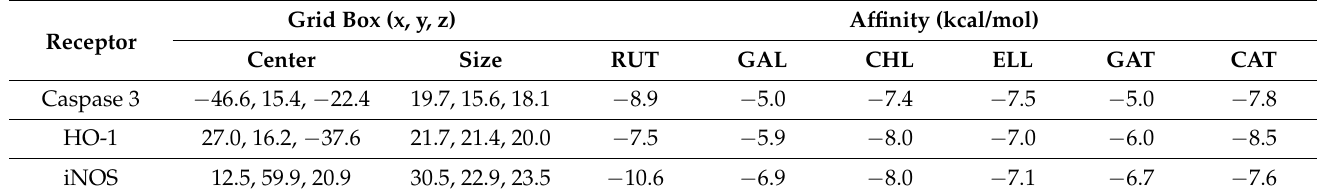
Table 2. The grid box parameter (center and size) and docking binding affinity (Kcal/mL) of RUT, GAL, CHL, ELL, GAT, and CAT for caspase-3, HO-1, and iNOS proteins. Grid Box (x, y, z) Affinity (kcal/mol) Receptor Center